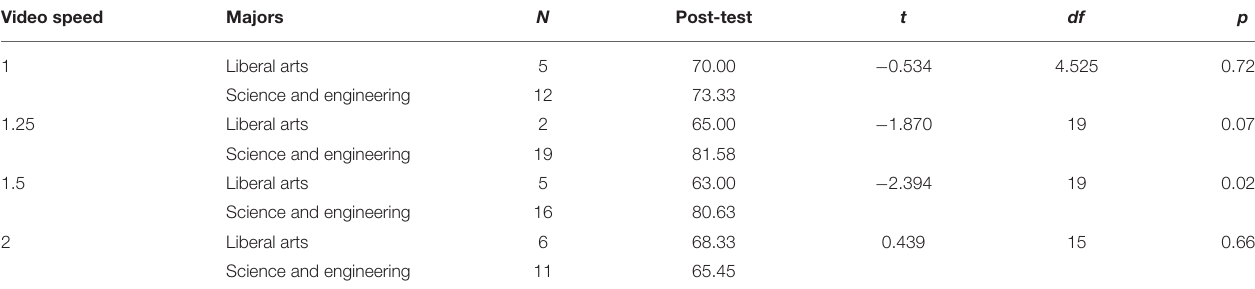
TABLE 3 | Influence of video speed and majors on learning effect shown by t -test analysis. Video speed